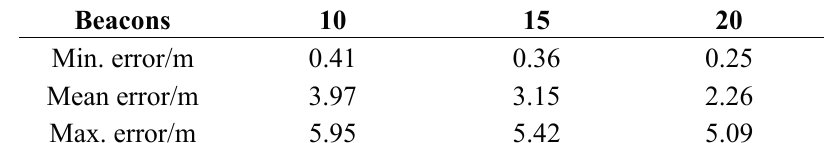
Table 5. Positioning error analysis for different numbers of Beacons.